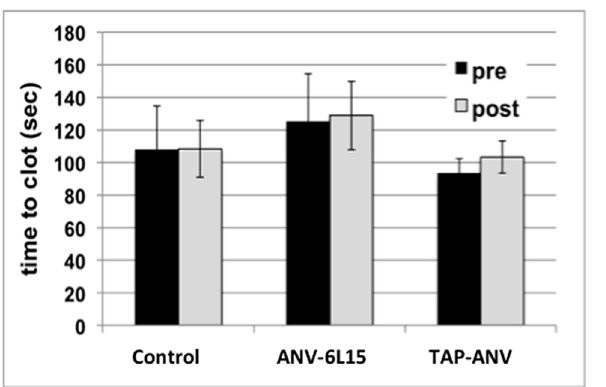
Fig 4. Point-of-care activated clotting times (ACT) in whole blood from heparin-treated (control), ANV- 6L15-treated and TAP-ANV-treated animals. Blood was collected before (pre) and immediately after (post) AVG creation surgery. There was no significant difference between paired pre-operative and post-operative values in any group. The bars represent means ±